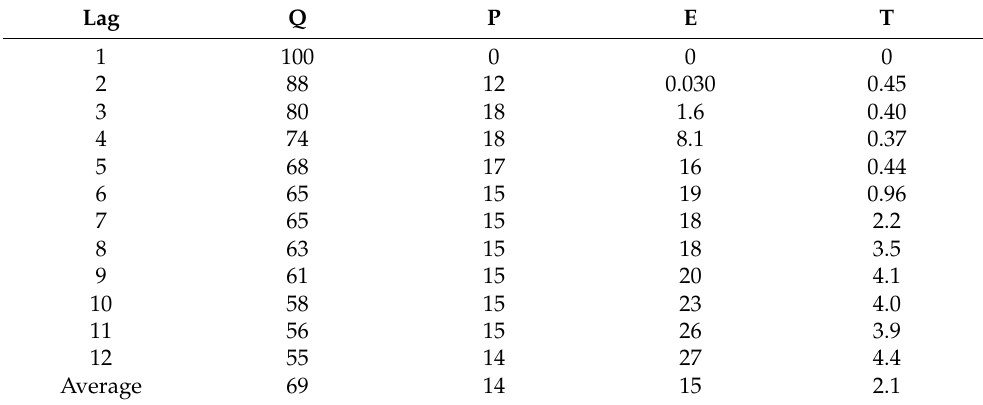
Table 7. Contribution rate of runoff by variance decomposition